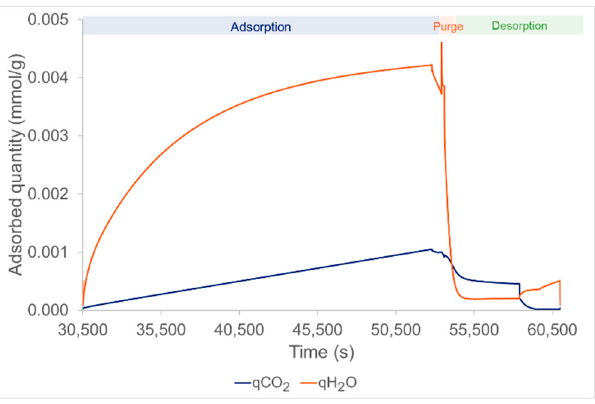
Figure 4. Adsorbed quantity of CO 2 (blue curve) and H 2 O (red curve) over time during a full cycle.